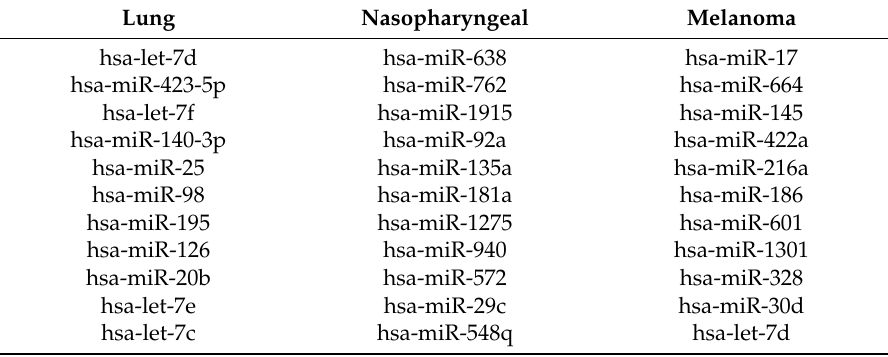
Table 5. The most frequent selected miRNAs by proposed algorithm.